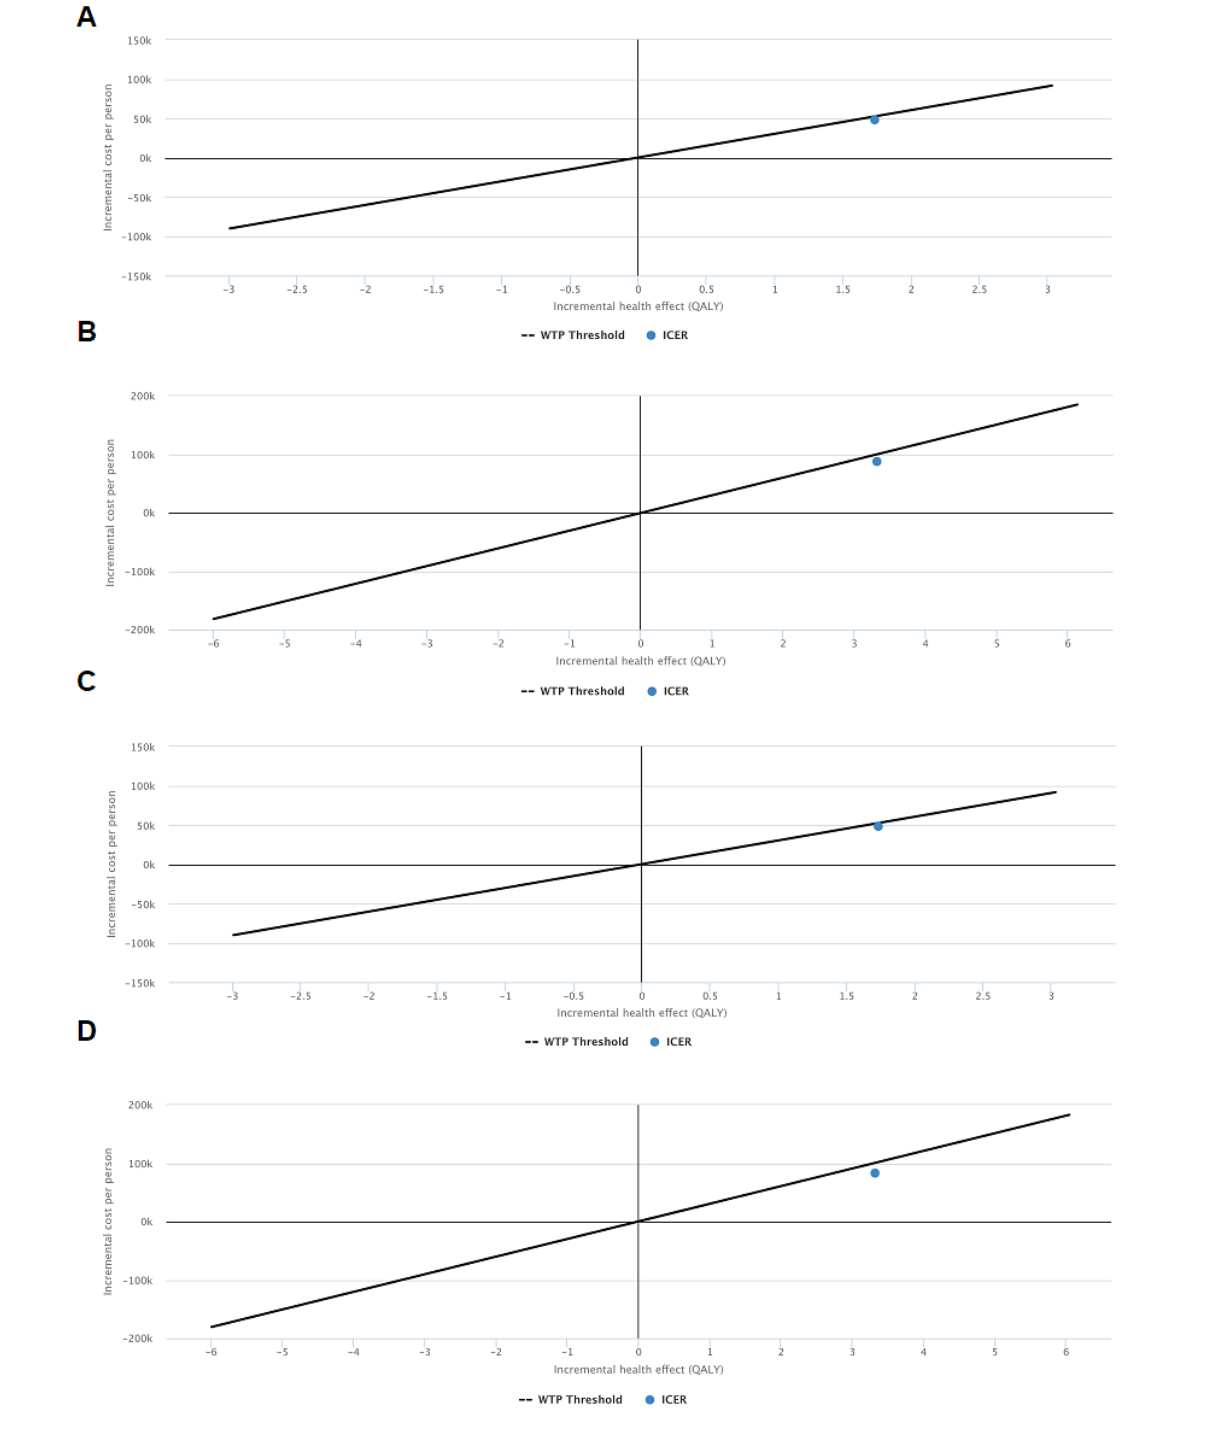
Figure 2. Cost-effectiveness plane of the Super@ intervention Healthcare perspective discounted (3% for both costs and health effects) (A) and non-discounted (B) analyses. Societal perspective discounted (3% for both costs and health effects) (C) and non-discounted (D) analyses. The solid line shows the 30,000 €/QAL Y willingness-to-pay threshold (equivalent to approximately US $36,060; an exchange rate of approximately €1 to US $1.20 is applicable at the time of publication). QALY: quality-adjusted life-year. WTP: